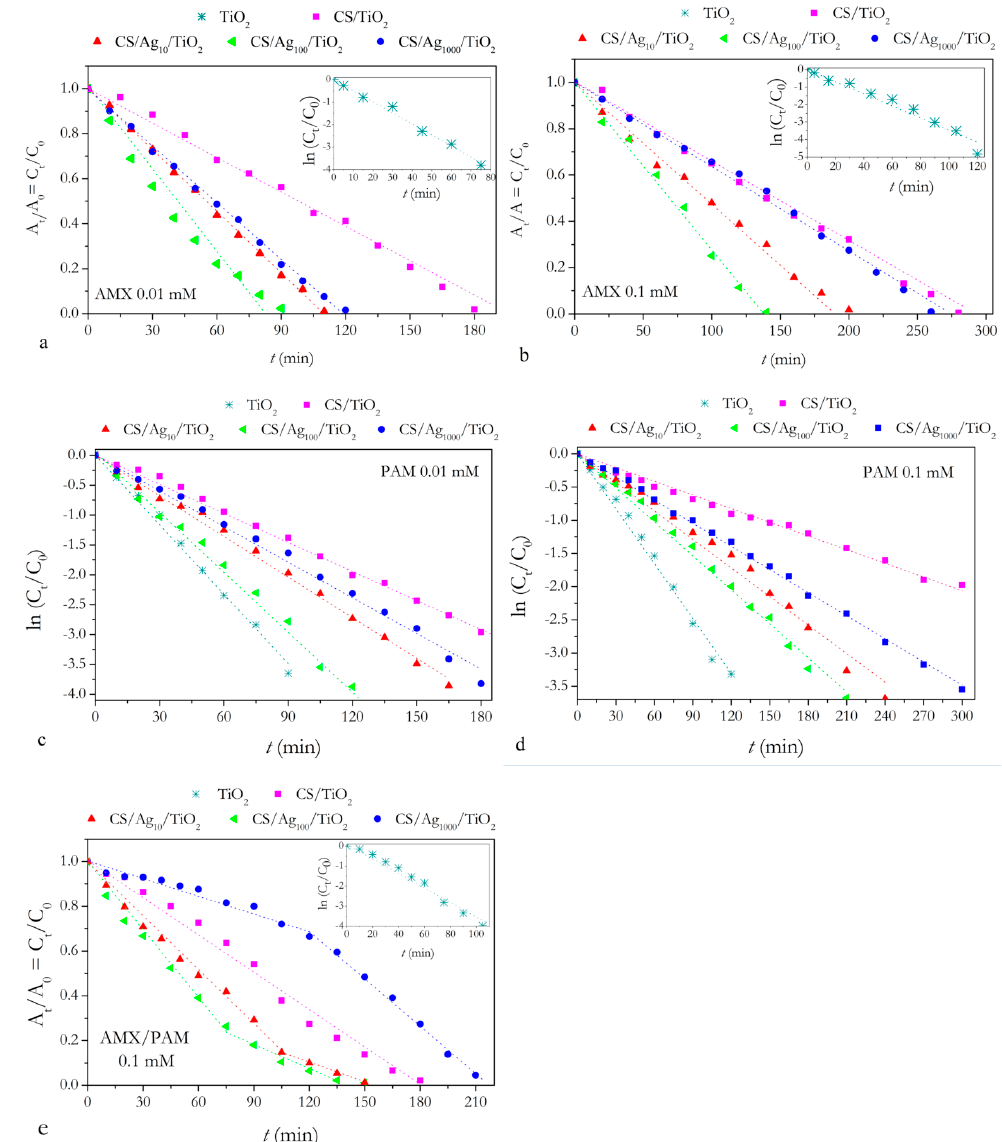
Figure 7. PZO pht ( a , b , e ) and PFO pht ( c , d ) linear fits to the photocatalytic degradation of PhCs. In the inserts, the PFO pht for TiO 2 catalyst. Two different degradation rates are found in ( e ) for CS/Ag xx /TiO 2.